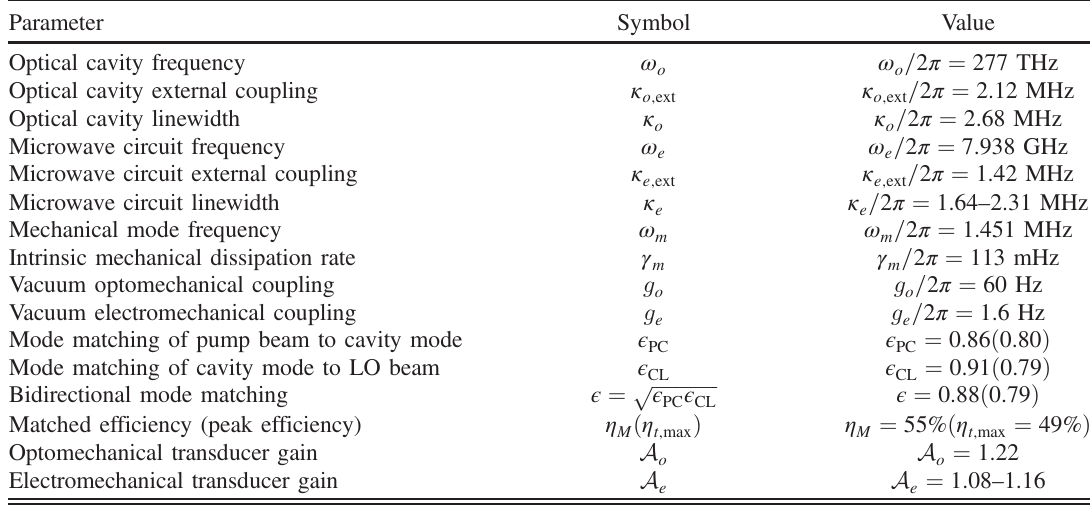
TABLE I. Electro-optic transducer parameters. The range of values for the microwave circuit linewidth κ correspond to the range of pump powers used in Fig. 3. For the optical cavity electromechanical transducer gain A e mode matchings and transducer efficiency, the first (second) numbers correspond to the data shown in Fig. 2 (Fig.